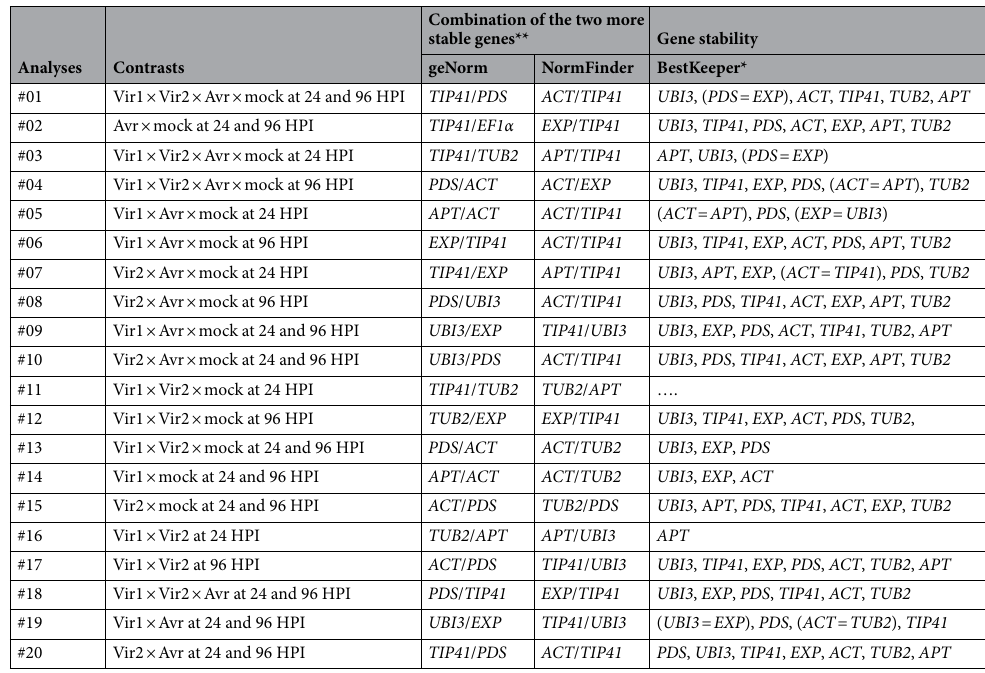
Table 1. Summary of analyses conducted in the development of stable sets of candidate reference genes for RT–qPCR across 20 comparisons involving interactions among the tomato inbred line ‘Hawaii 7996’, two virulent/compatible Ralstonia solanacearum isolates (Vir1 = RS 488 and Vir2 = CCRMRs223) and one avirulent/incompatible R. solanacearum isolate (Avr = RS 489). Biological samples were collected at 24- and 96-h post-inoculation (HPI) from entire tomato seedlings (aerial parts + root systems) inoculated with these distinct R. solanacearum isolates. The set of analyses involving all contrasts among compatible and incompatible interactions at 24 and 96 HPI was named as “Global Interaction”—GI (= analysis #01), whereas the set of analyses involving samples of the avirulent/incompatible isolate at 24 and 96 HPI was named as “Global Incompatible Interaction”—GII (= analysis #02). *Gene stability ranking (higher to lower). Unlisted genes showed standard deviation values (std dev [± CP]) > 1.0. ** Code for the genes/alleles employed in the assays: actin ( ACT ), adenine–phosphoribosyl–transferase 1 (A PT ), β–2–tubulin ( TUB2 ), elongation factor 1– alpha ( EF1α ), the Arabidopsis thaliana expressed protein ( EXP ), TIP41–interacting protein ( TIP41 ), phytoene desaturase ( PDS ), and ubiquitin ( UBI3 ). = means that all genes have identical ranking position.